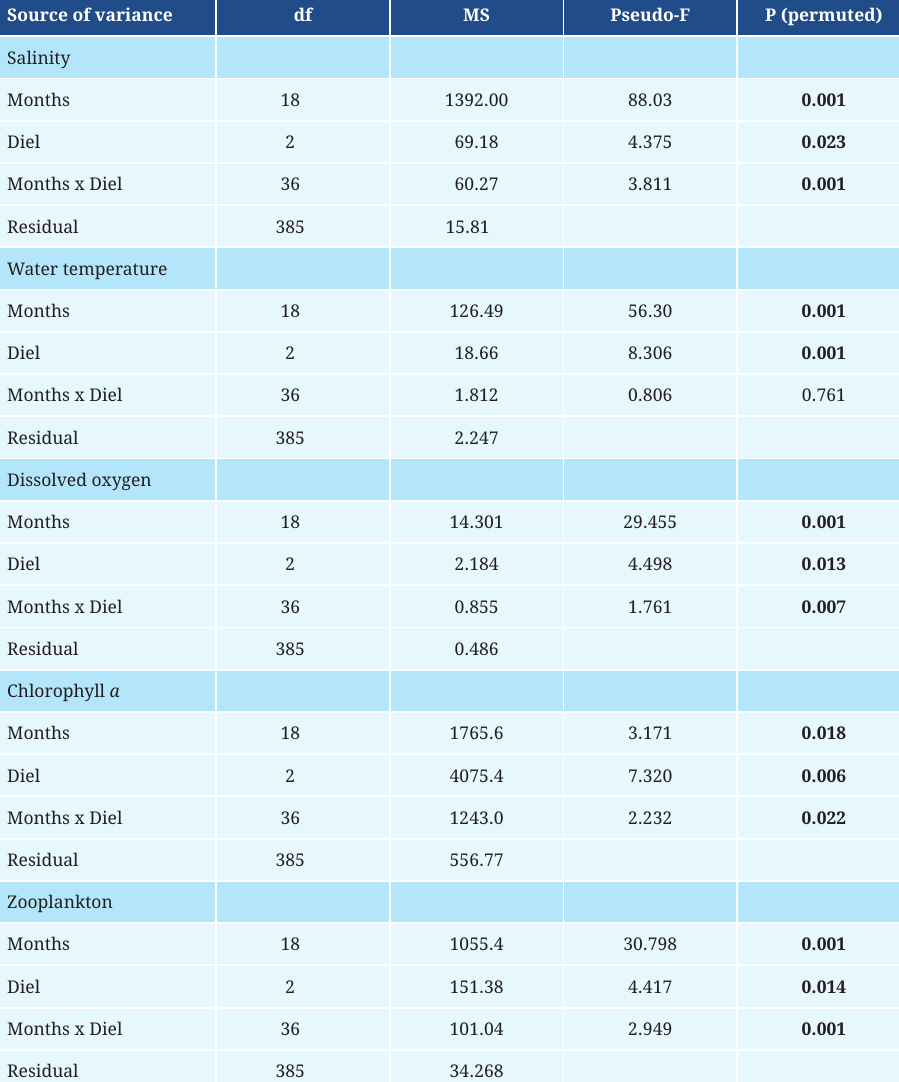
TABLE 2 | Univariate two-way PERMANOVA to test the effects of months and diel period (daytime, twilight, and nighttime) on the in situ environmental variables studied. Significant P values are shown in Source of variance df MS Pseudo-F P (permuted) Salinity 18 1392.00